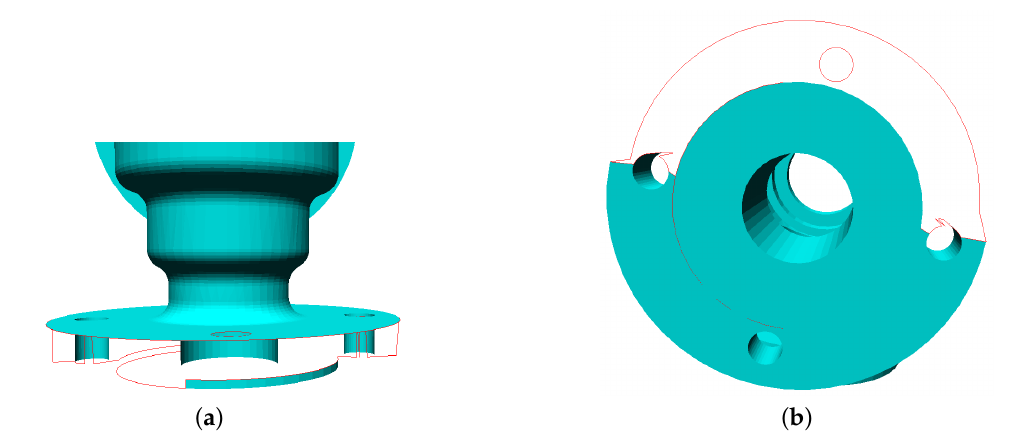
Figure 6. Result of border identification in the triangle set. ( a ) and ( b ) present the identified border of the triangle set after weaving the